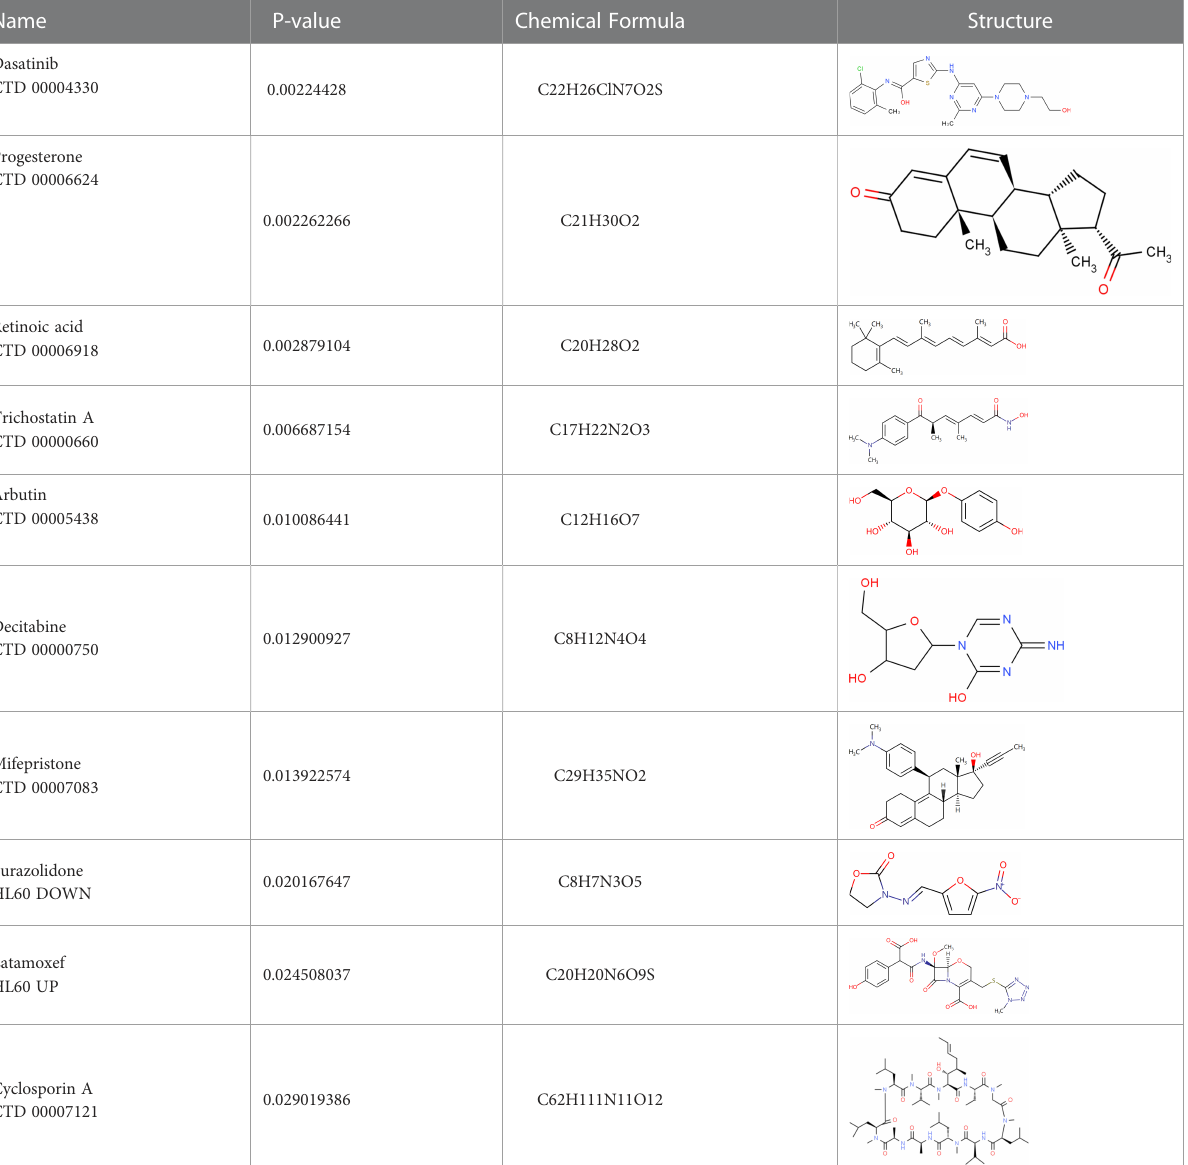
TABLE 2 The top 10 recommended drugs.